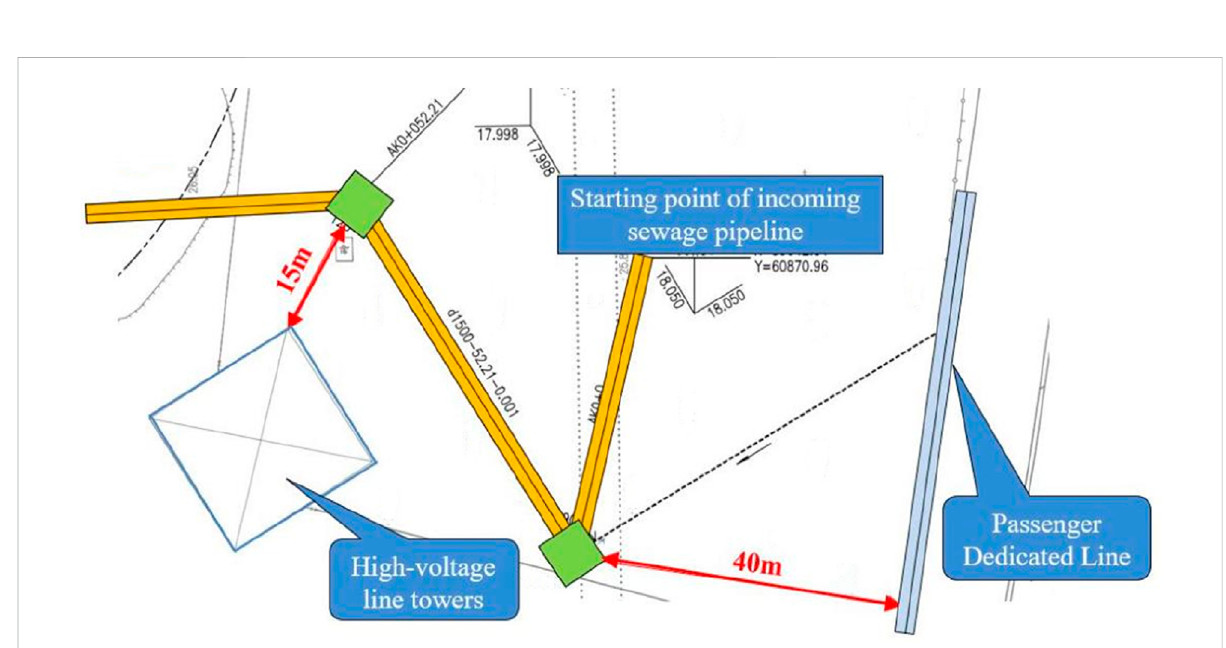
FIGURE 3 Location of the pipeline from the high-speed railway and transmission